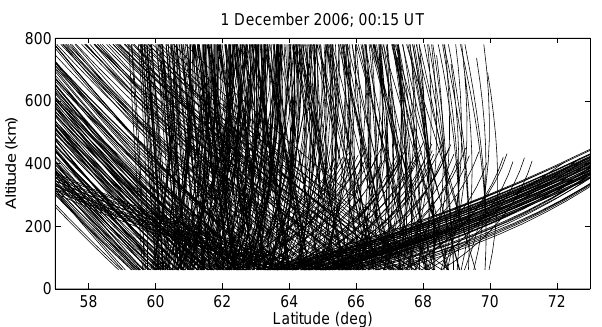
Fig. 3. Example of the measurement paths inside the grid of one inversion, projected onto the latitude–altitude